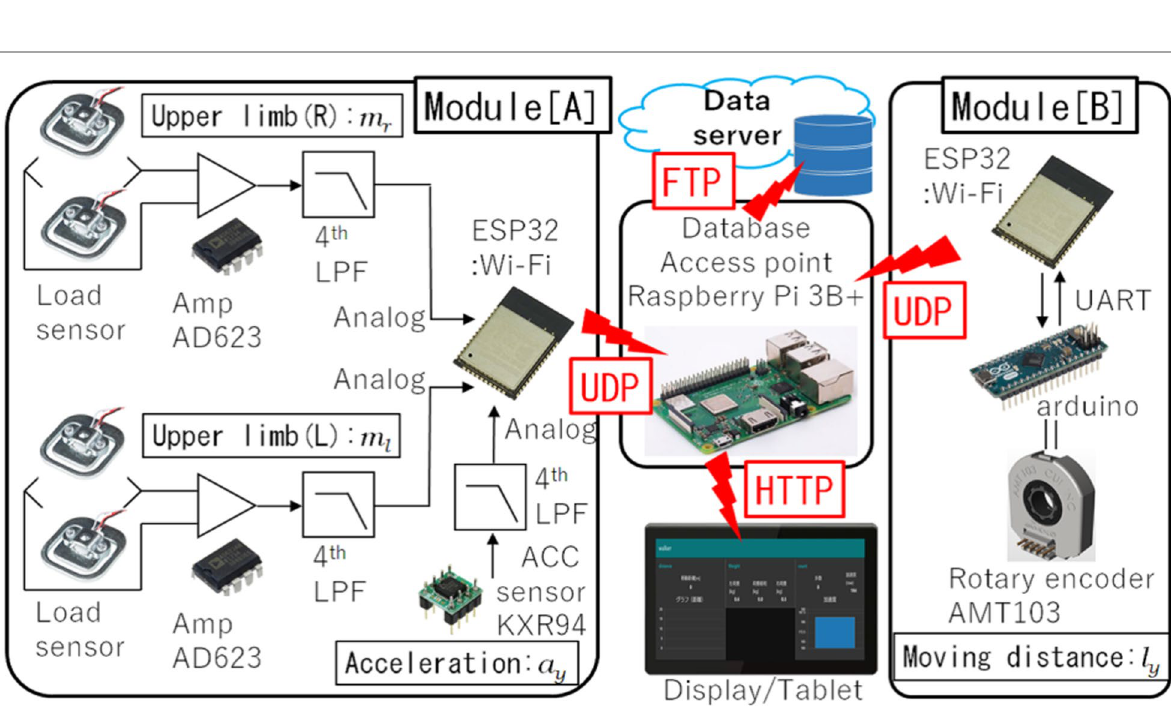
Fig. 5 Conceptual system diagram of the rolling stand-up walker measurement system—the Module [A] has left and right load sensors ( m l , m r ) and acceleration sensors ( a y ), and Module [B] has a rotary encoder for measuring the distance ( l y